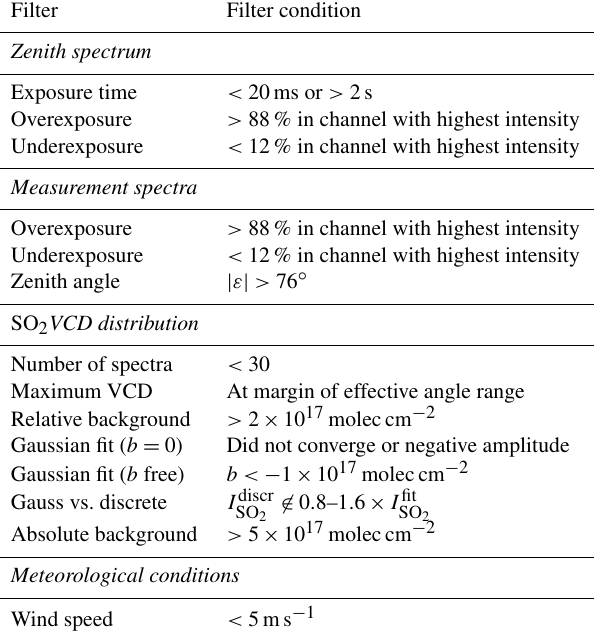
Table 2. Applied filters in chronological order (if condition ful- filled, reject data). See text for details. For comparison, the standard NOVAC retrieval applies the five following filter conditions (Jo- hansson et al., 2009): (1) overexposure of (any) spectrum by more than 99%, (2) underexposure of (any) spectrum by less than 2.5%, > 0 . 9 for a measurement spectrum, (4) number of passing (3) χ 2 SO 2 spectra < 10, and (5) a “plume completeness filter” which rejects a scan if most of the large dSCDs are close to the margin of the effective angle